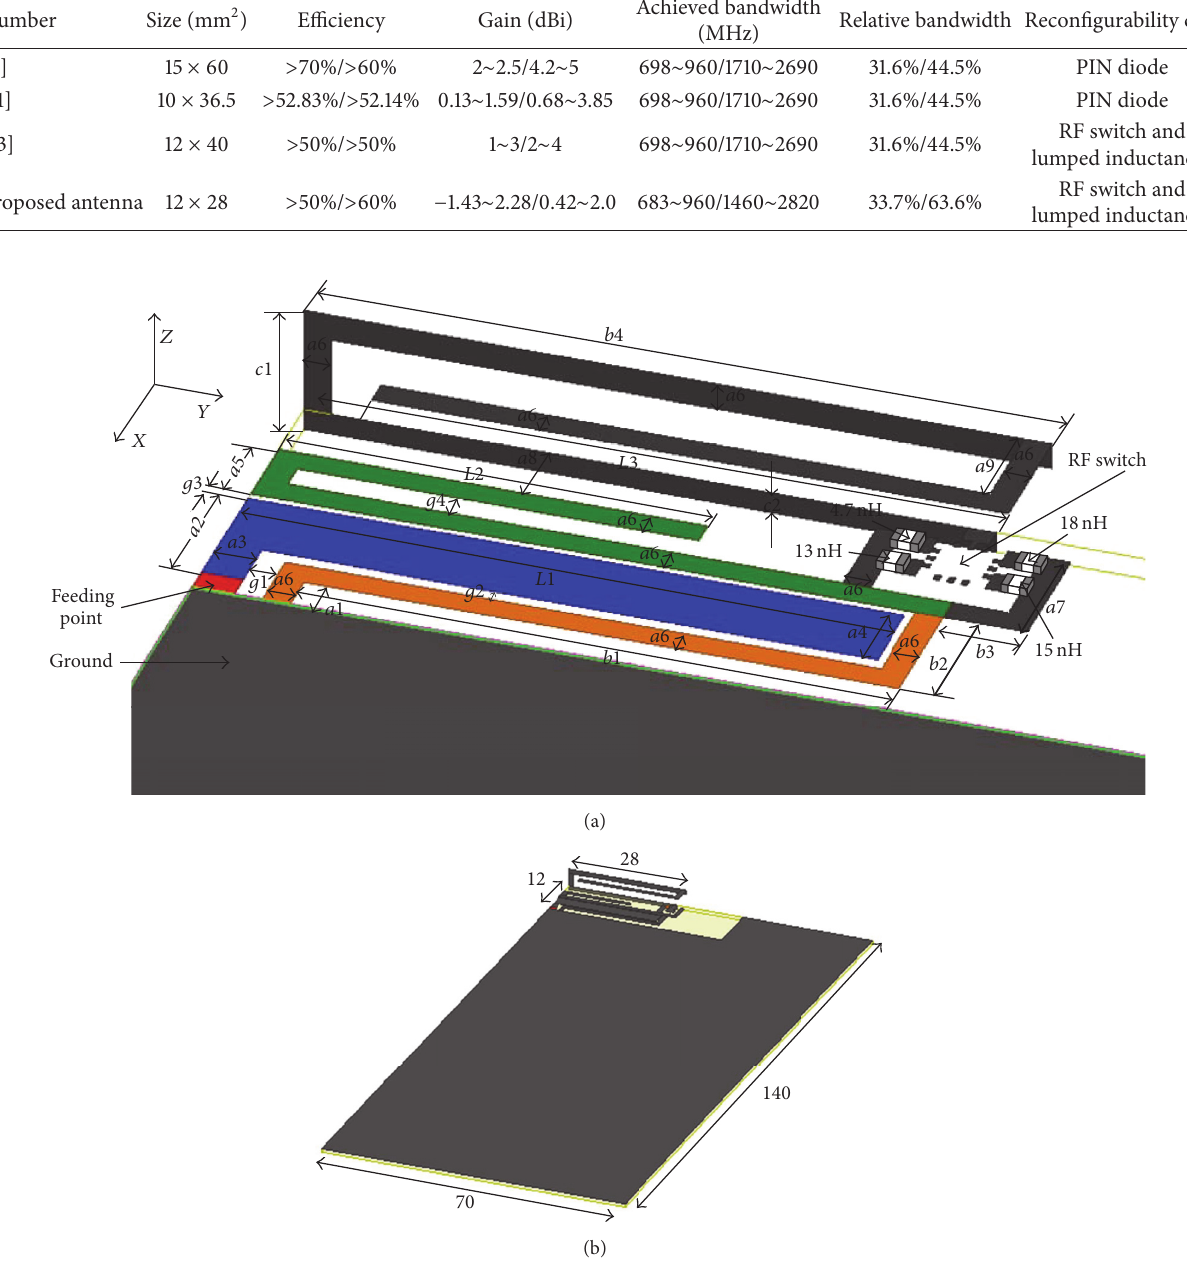
Figure 1: Geometry of the proposed antenna. (a) Detailed dimensions. (b) Overall